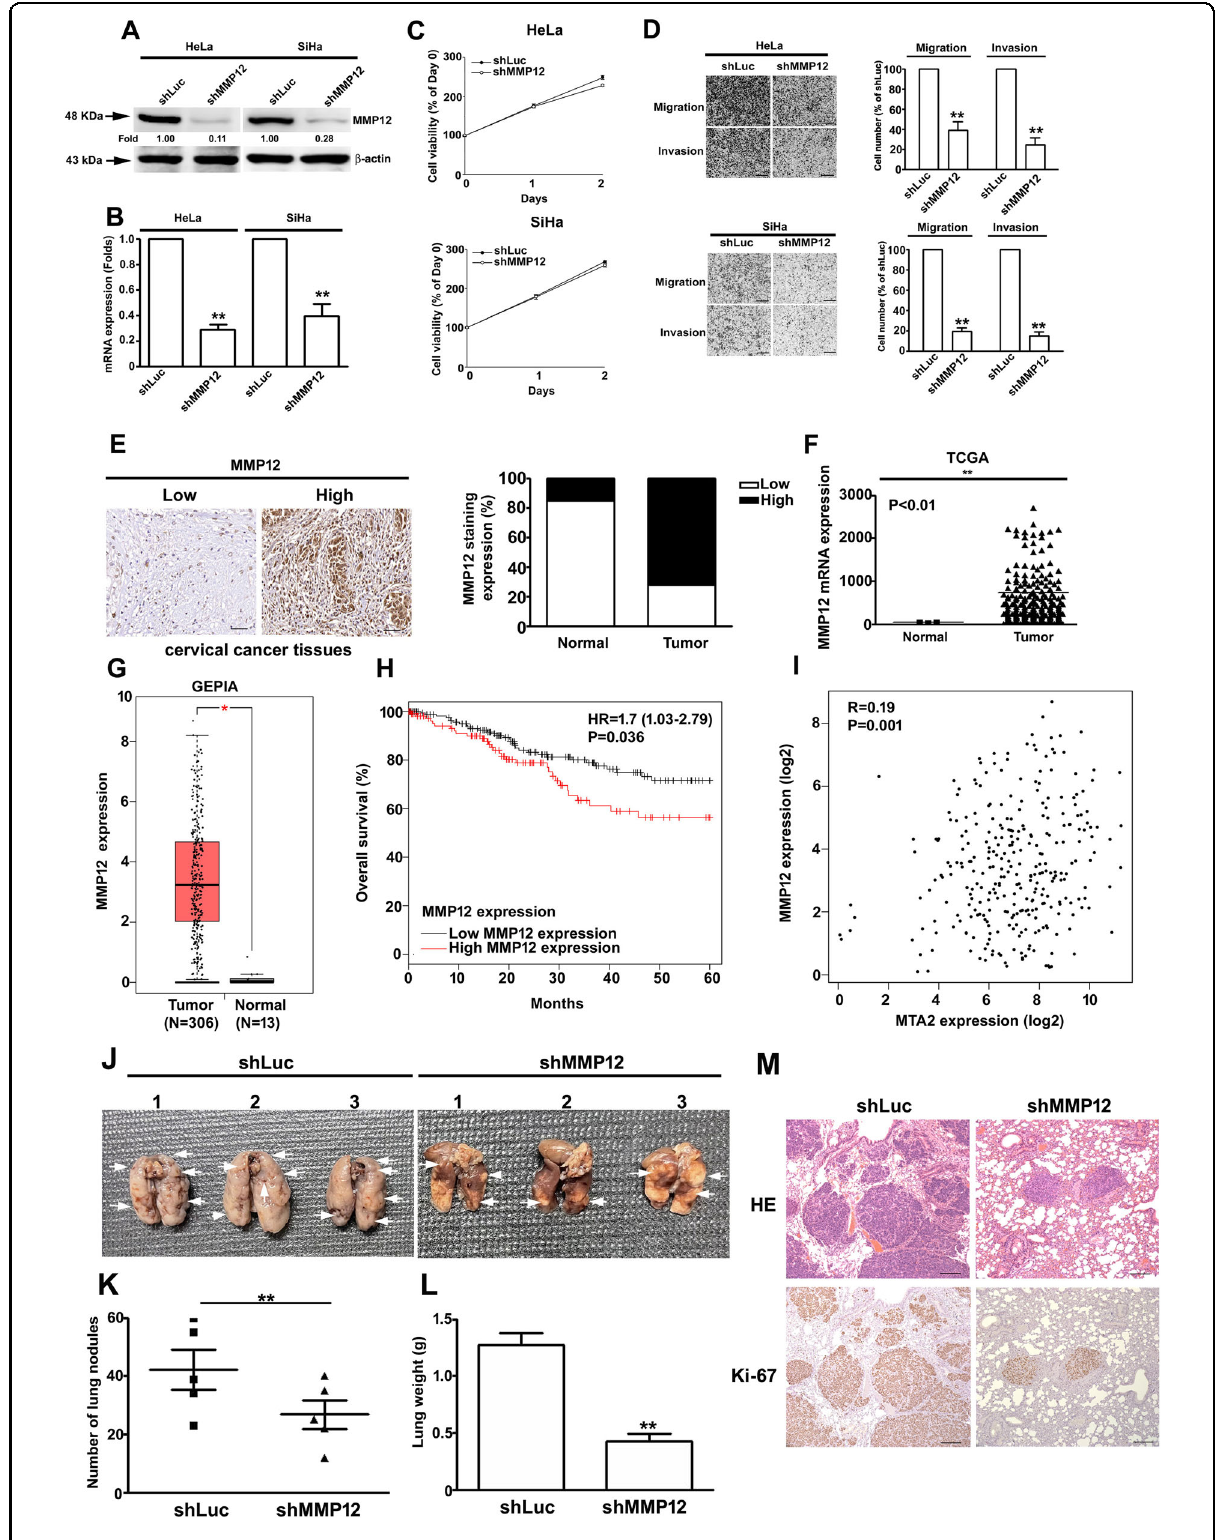
Fig. 2 (See legend on next